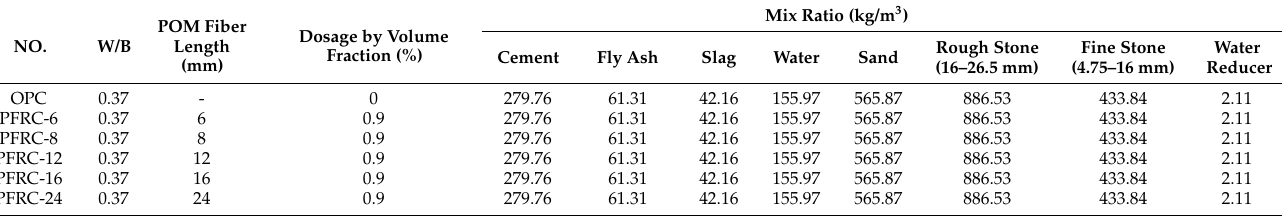
Table 3. Material properties of blast furnace slag powder.